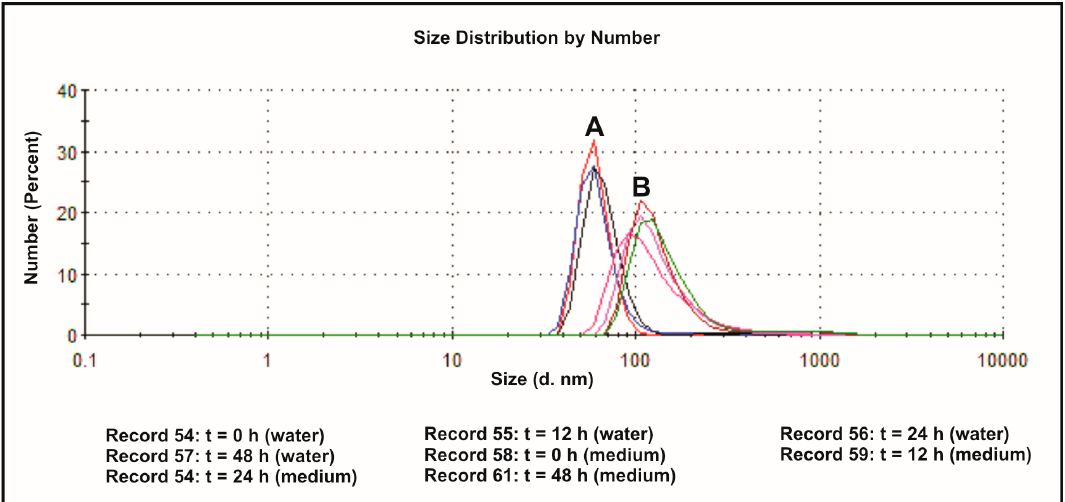
Figure 2. Size distribution of 5–15 nm SiNPs determined by DLS measurements: dispersed in deionized water ( A ), and dispersed in DMEM with 10% of FBS ( B ). Representative images generated by Zetasizer Nano ZS are presented.